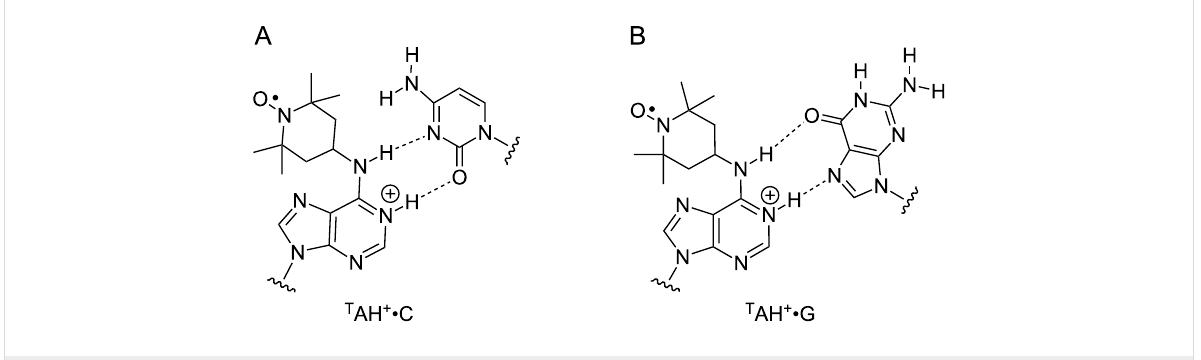
Figure 3: Possible base pairing of T AH + with C (A) and G (B) at pH 5.